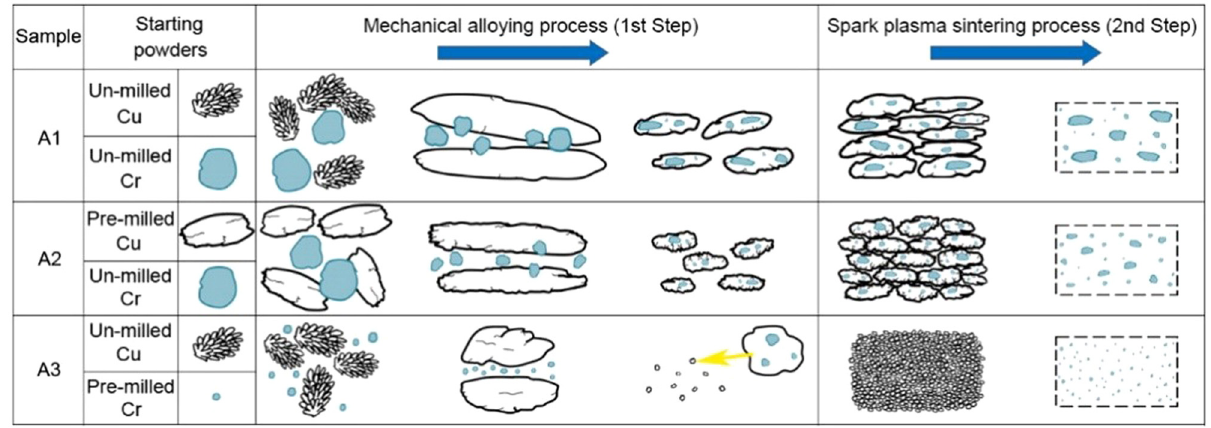
Figure 3: Size and distribution of reinforcement in the matrix after mechanical alloying and SPS processes [ 76 ] .